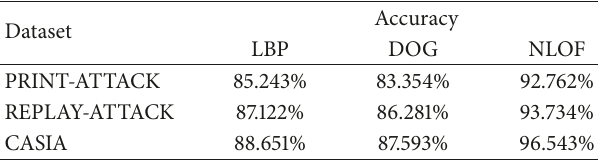
Table 6: Compared the fusion algorithm of this experiment on different